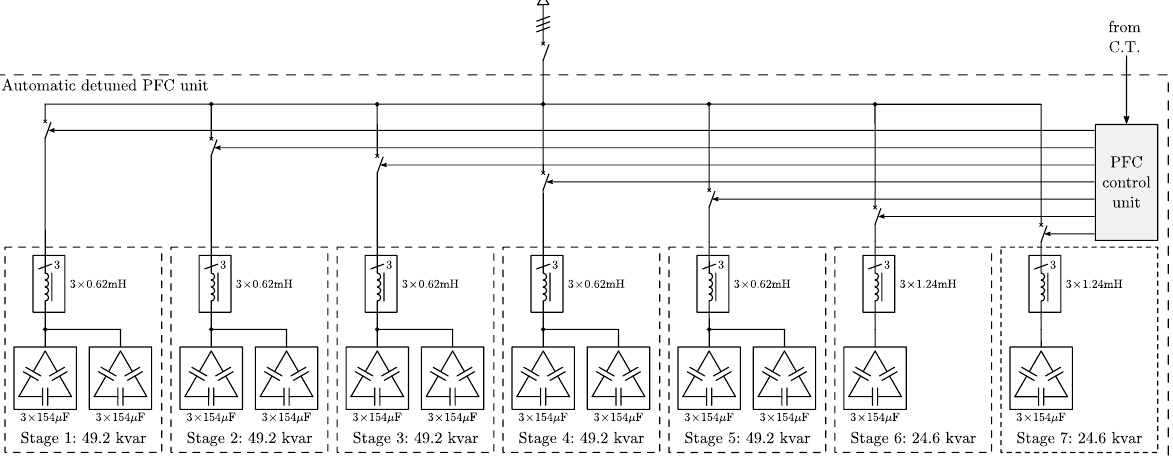
Figure 7. Single-line diagram of the automatic detuned PFC